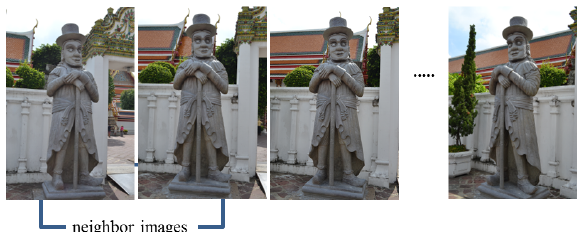
Figure 3: Image acquisition, neighbor images are recommended to capture at 60% (or more) for overlapped region.